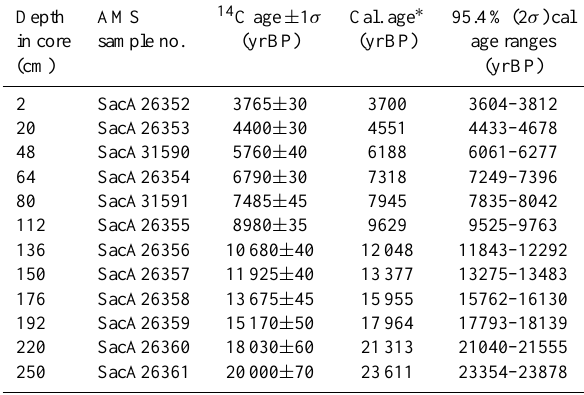
Table 1. Radiocarbon ages for core